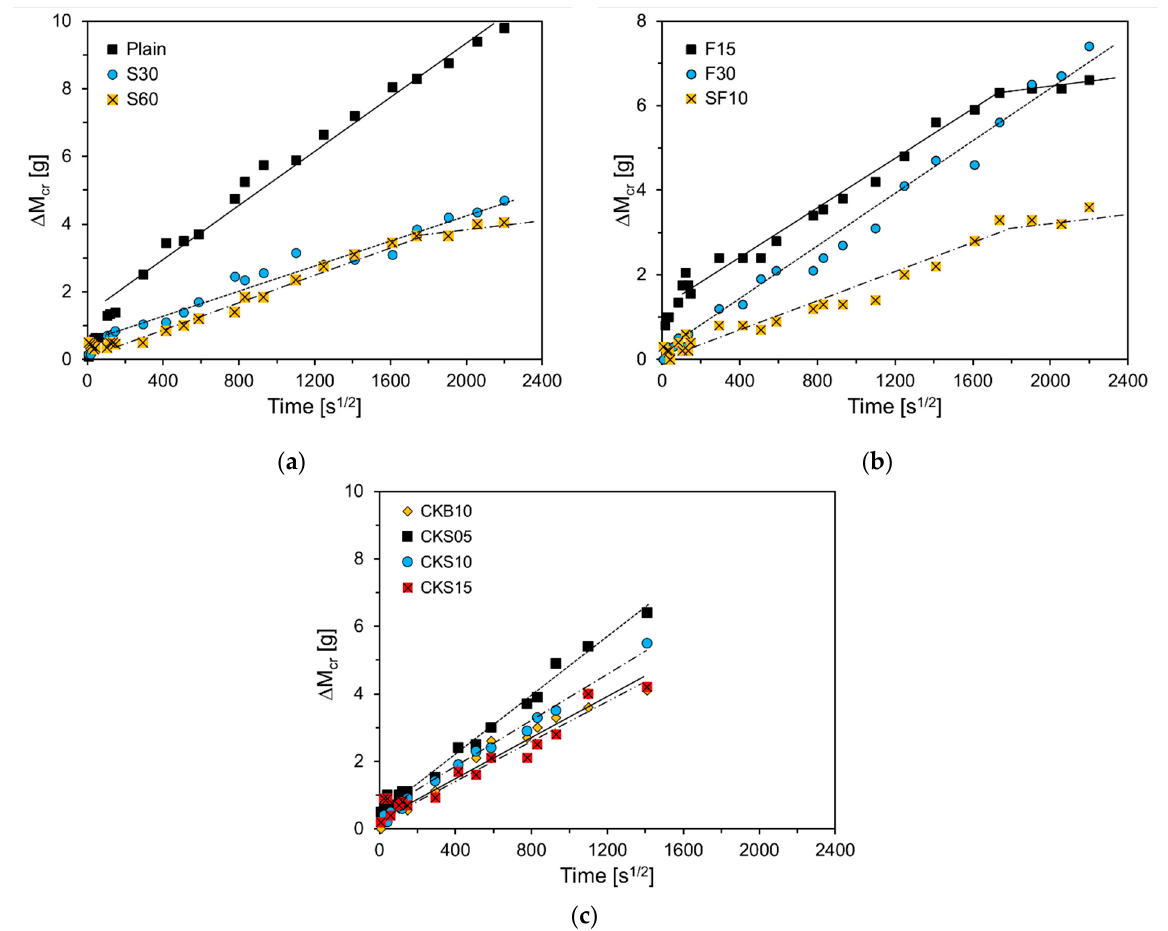
Figure 7. Difference in absorption rates between cracked and uncracked specimens: ( a ) Plain, S30, S60; ( b ) F15, F30, SF10; ( c ) CKB10, CKS05, CKS10, CKS15.